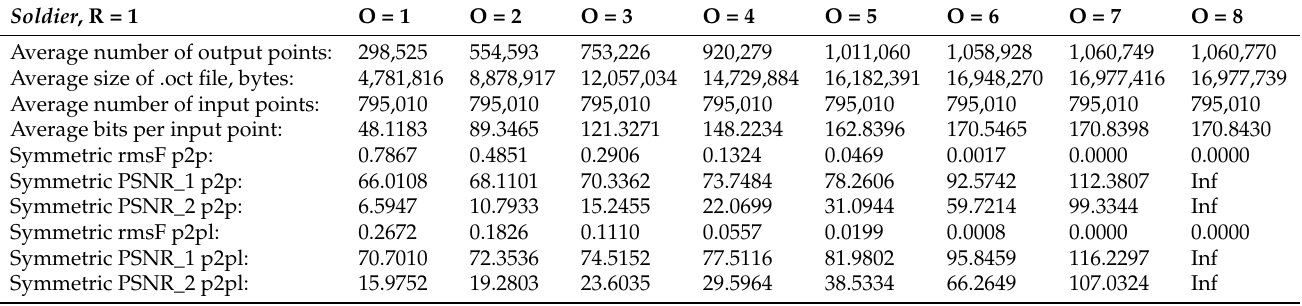
Table 15. Octree reduction using 3DTK toolkit, with voxel size “R” = 1 and different parameters for randomized octree based point reduction with “O” points per voxel, for the Soldier point